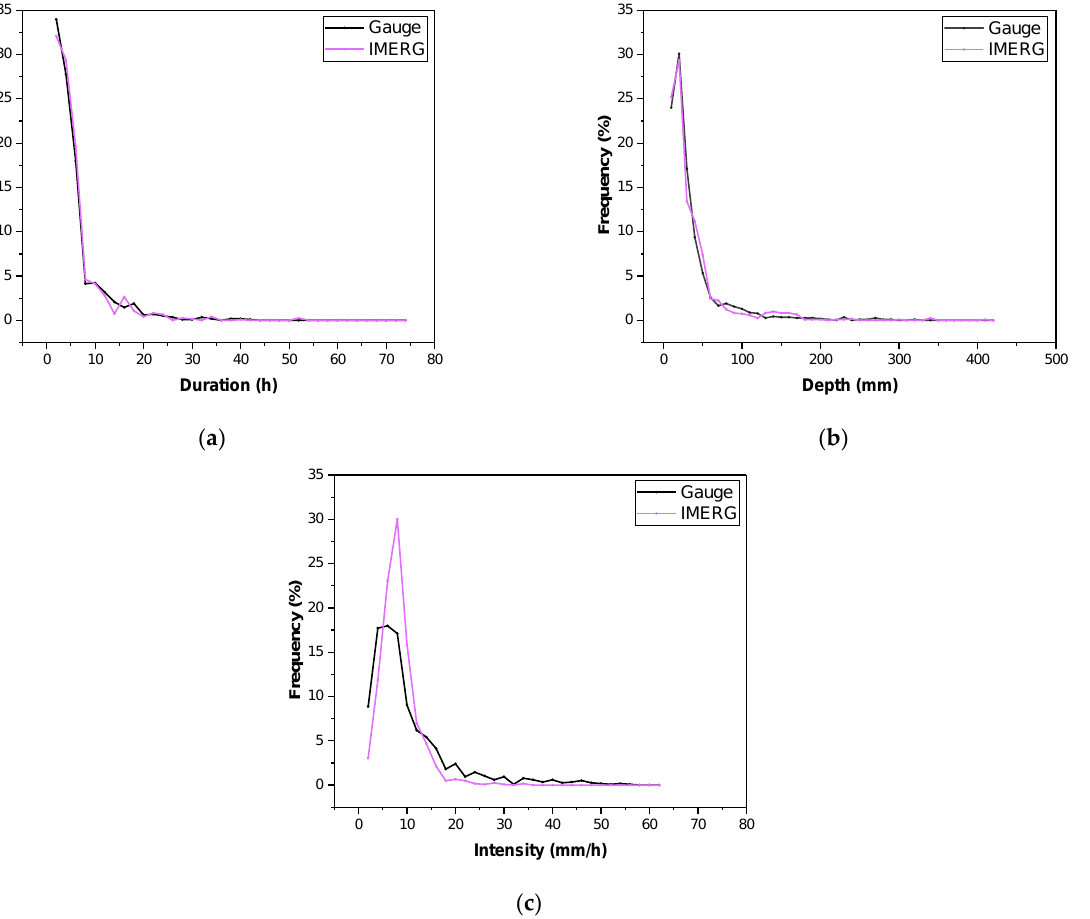
Figure 8. Probability distribution function of ( a ) rainfall duration, ( b ) rainfall depth, and ( c ) rainfall intensity at event time scale for ground-based rain gauges and IMERG data from September 2018 to August 2020.